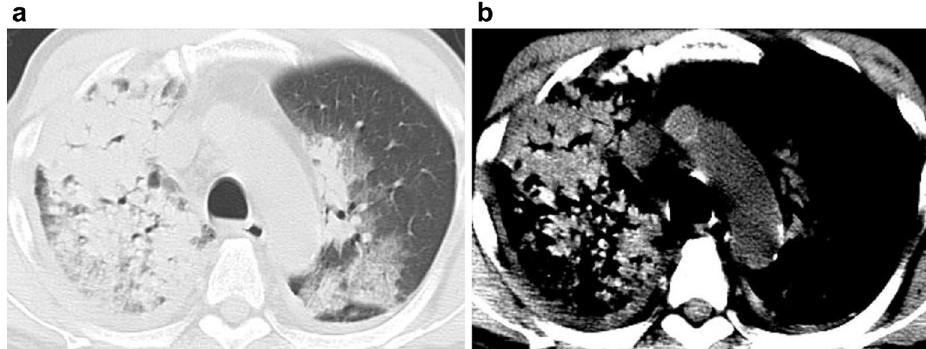
Figure 3. 70-year-old man with diffuse alveolar hemorrhage in microscopic polyangiitis. ( a ) Transaxial CT with a lung window setting showing the consolidations and ground-glass opacities. ( b ) The hyperdense consolidation sign is seen in the narrow window setting with a mediastinal filter.